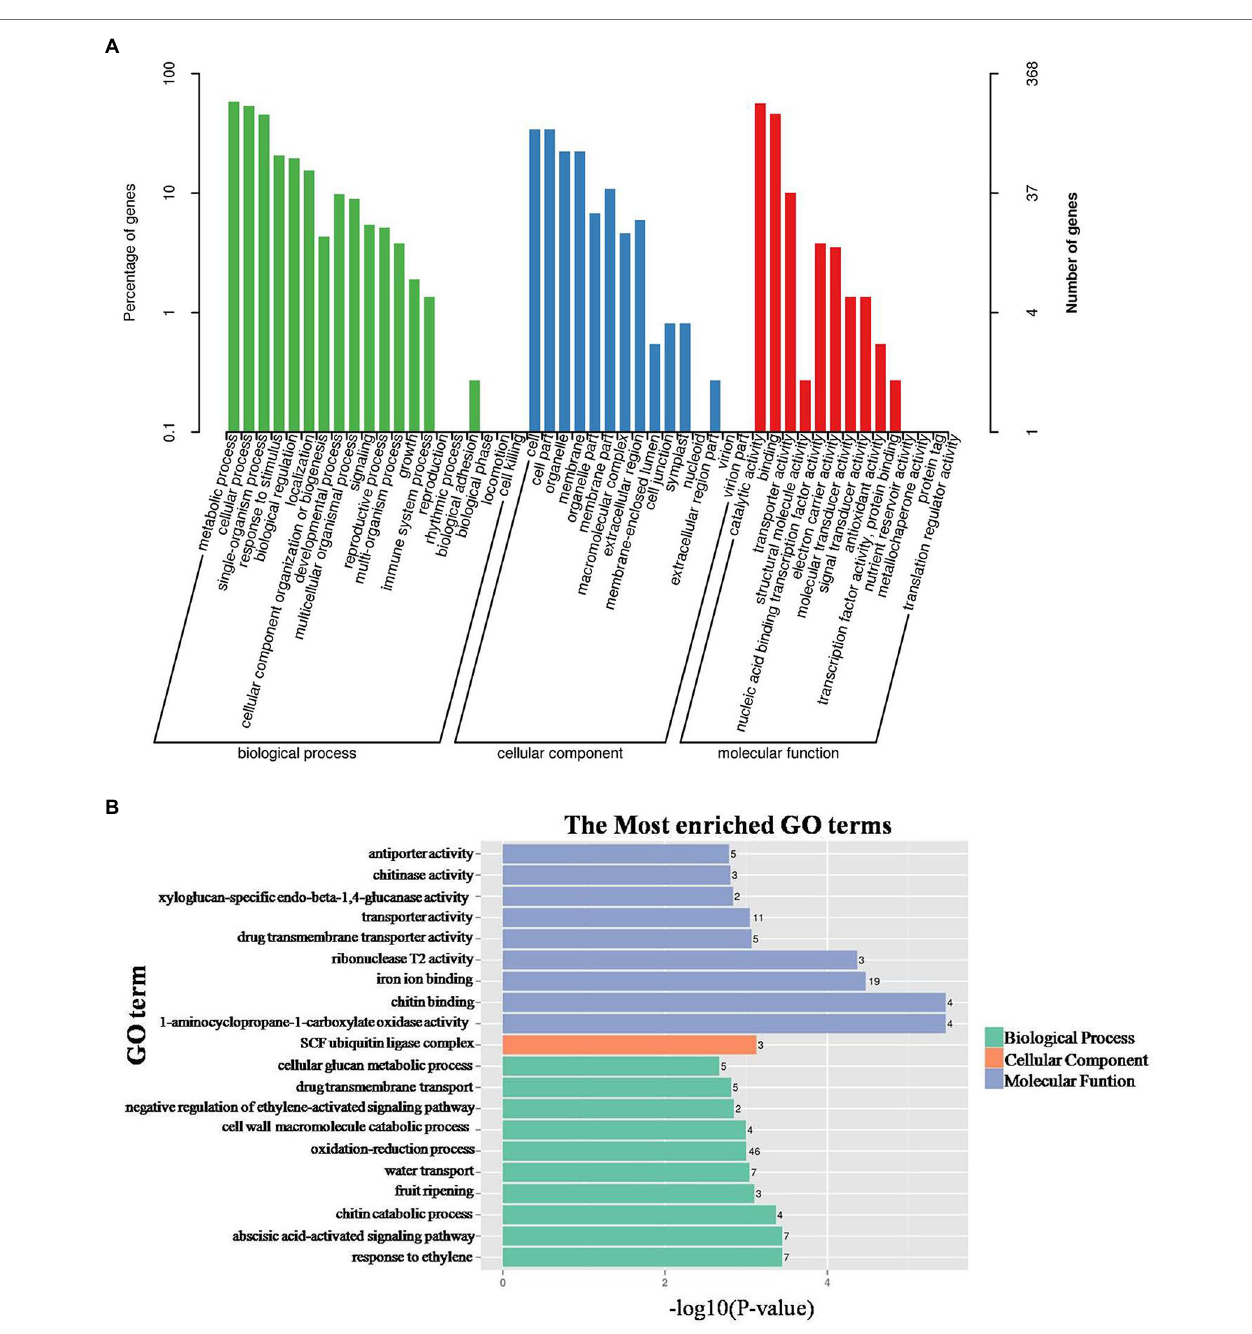
FIGURE 3 | Gene ontology (GO) analysis of DEGs between control and ethephon-treated shoot apical meristem of pumpkin. (A) GO categories. (B) Enrichment analysis of DEGs in biological processes, cellular components, and molecular functions category. The number of DEGs enriched in each term is marked on the